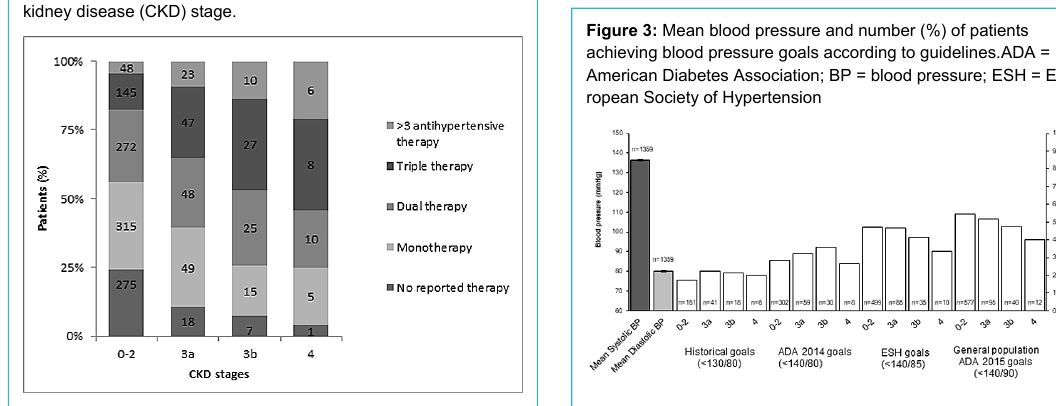
Figure 2: Number and % of anti-hypertensive therapy by chronic kidney disease (CKD) stage.